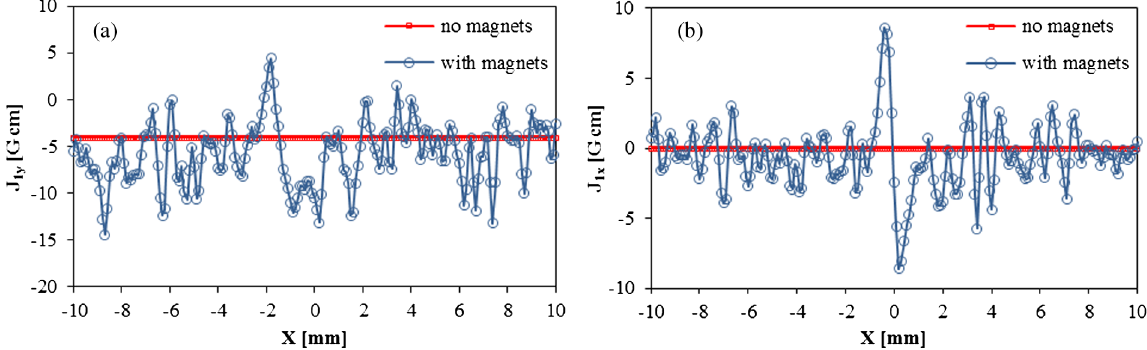
FIG. 5. J 1 y vs x (a) and J 1 x vs x (b) calculations with and without magnets for UNA33